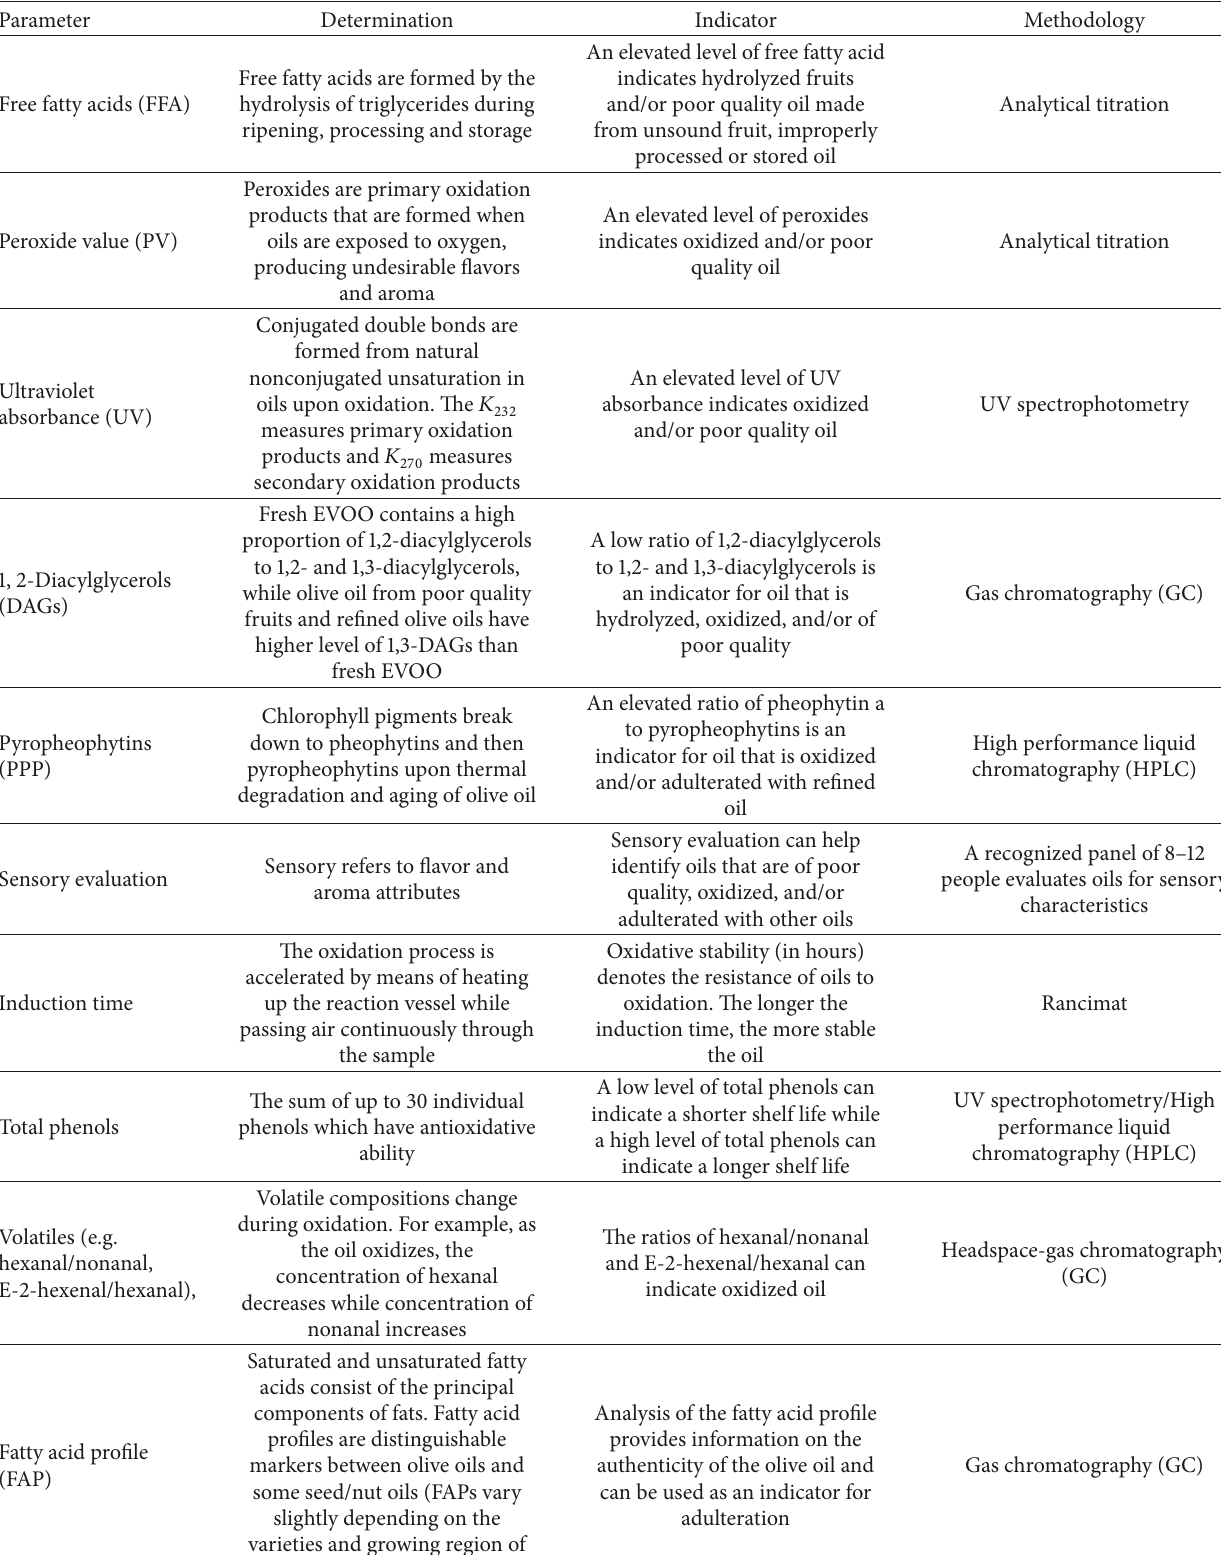
Table 1: Critical chemical parameters used in olive oil shelf-life prediction model